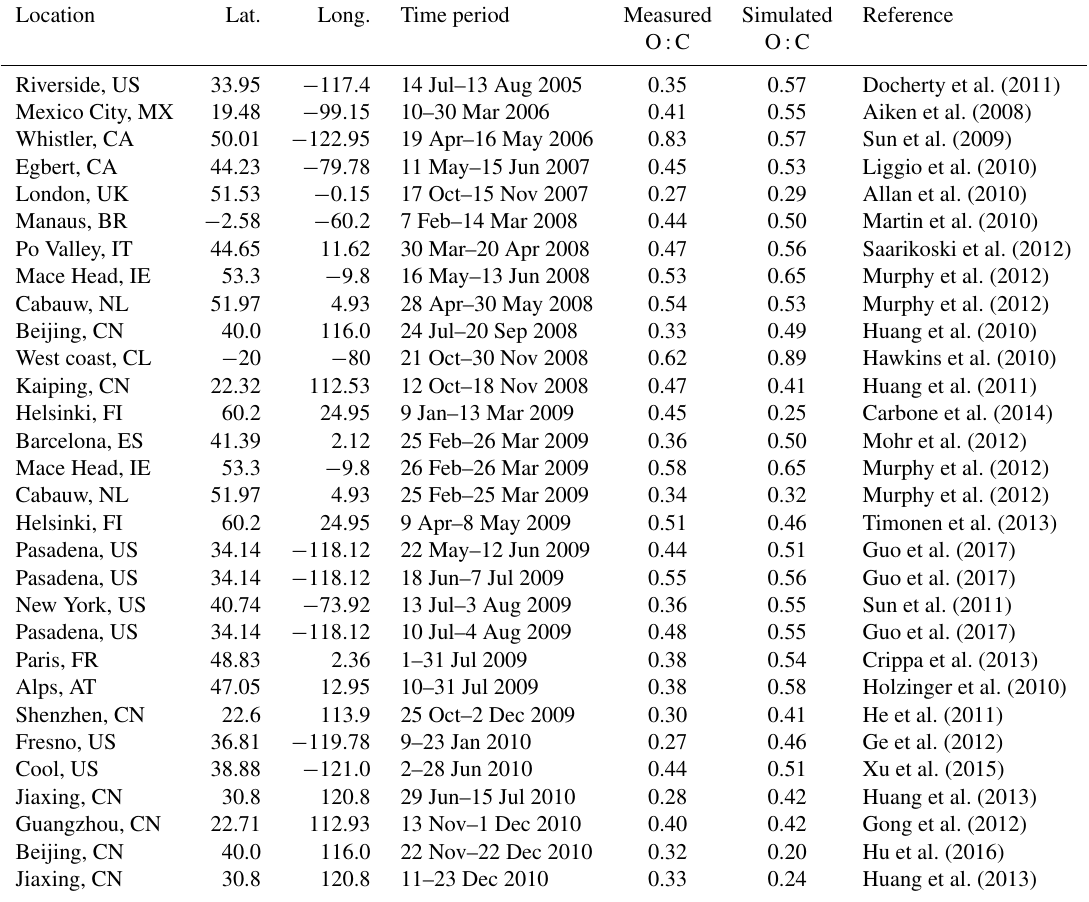
Table 5. Worldwide O:C ratio predictions and observations of total OA. Location Lat. Long. Time period Measured Simulated Reference